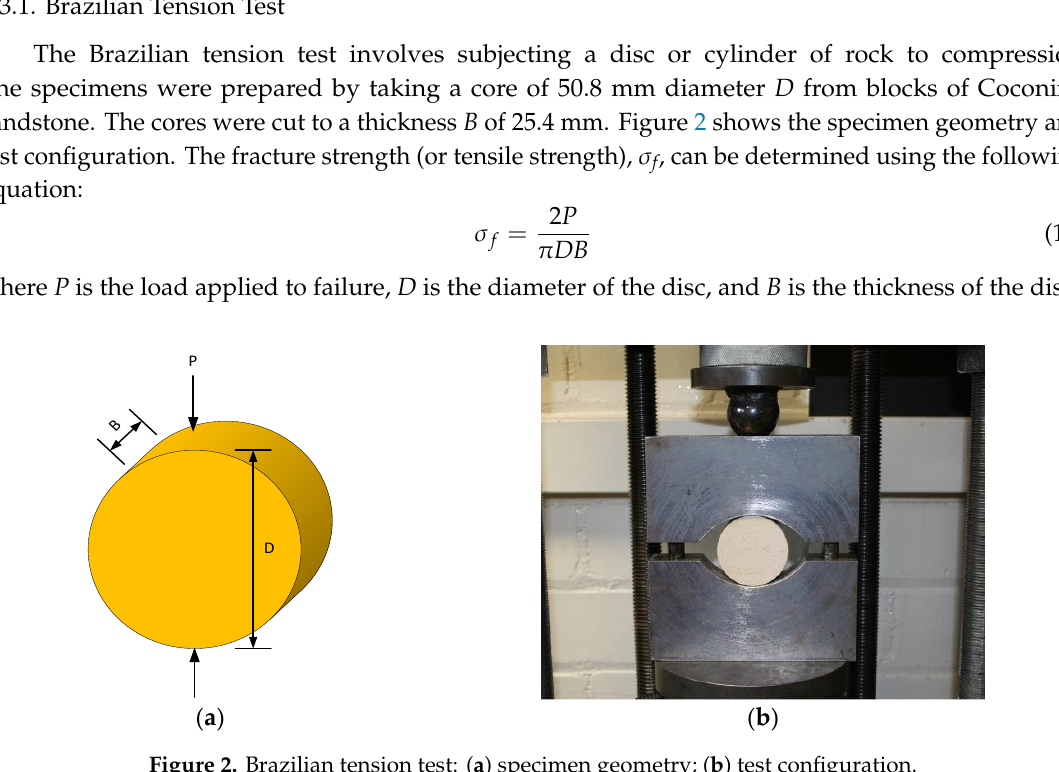
Table 1. Material properties of Coconino sandstone.